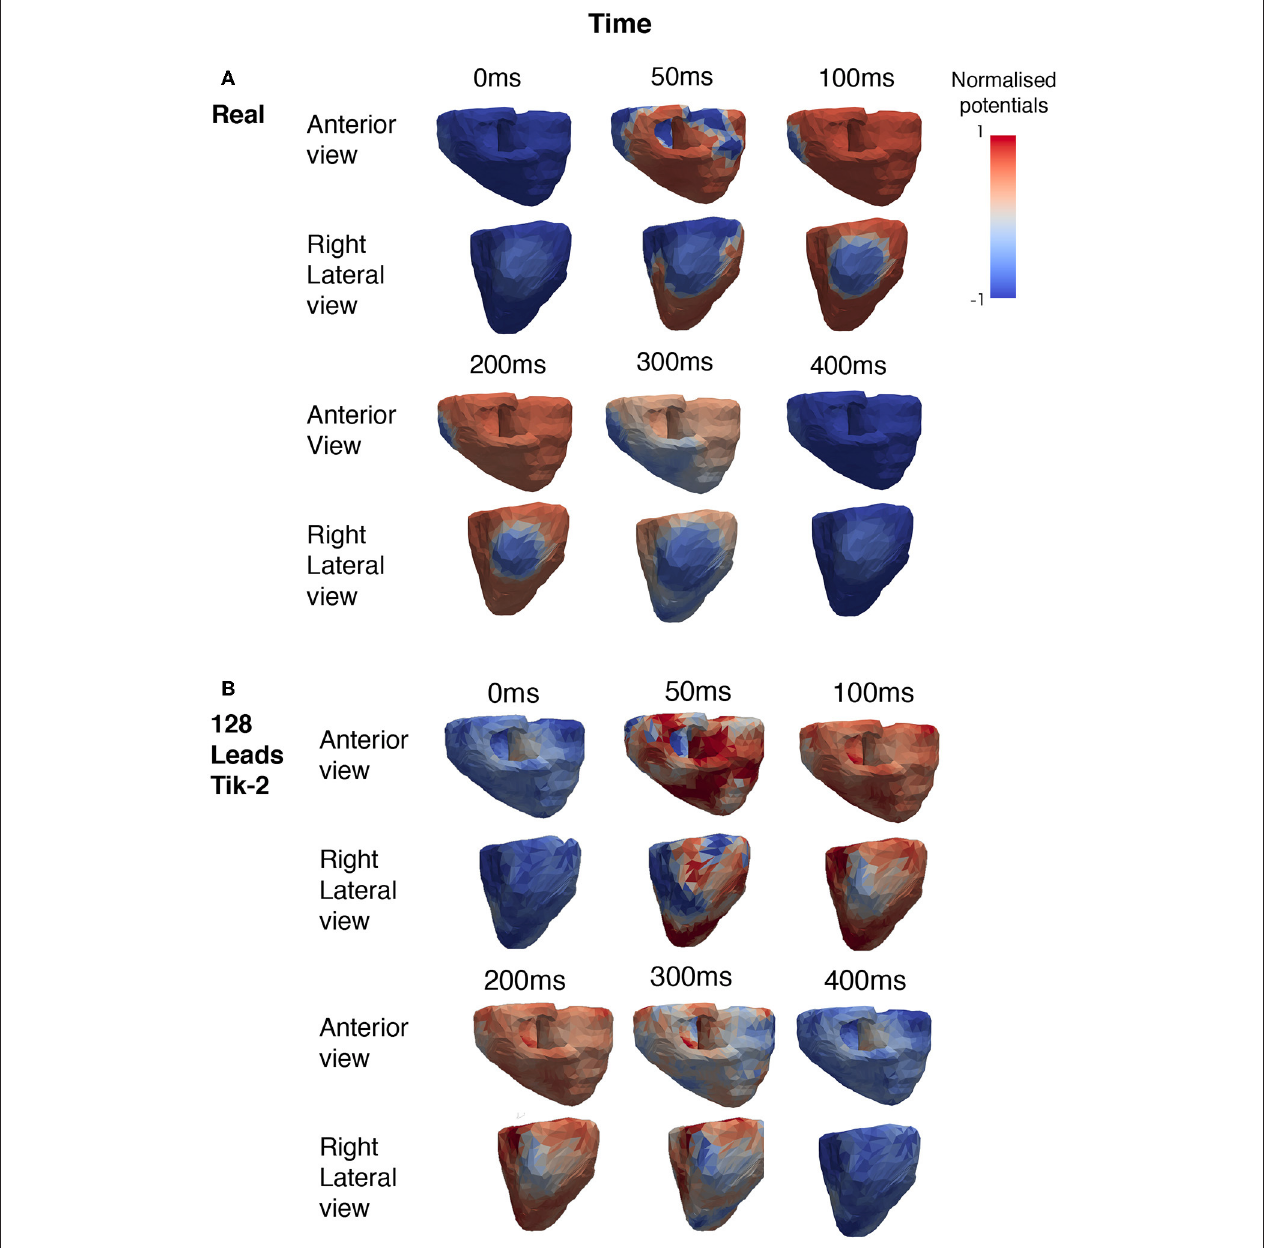
FIGURE 4 | Snapshots showing the comparison between real and reconstructed epicardial excitation pattern. Both anterior and right lateral view of the ventricle were shown for over a period of 400ms. (A) Real epicardial potential patterns at different timings. (B) Reconstructed epicardial potential pattern at different timings by using 128 leads and the 2nd order Tikhonov regularisation